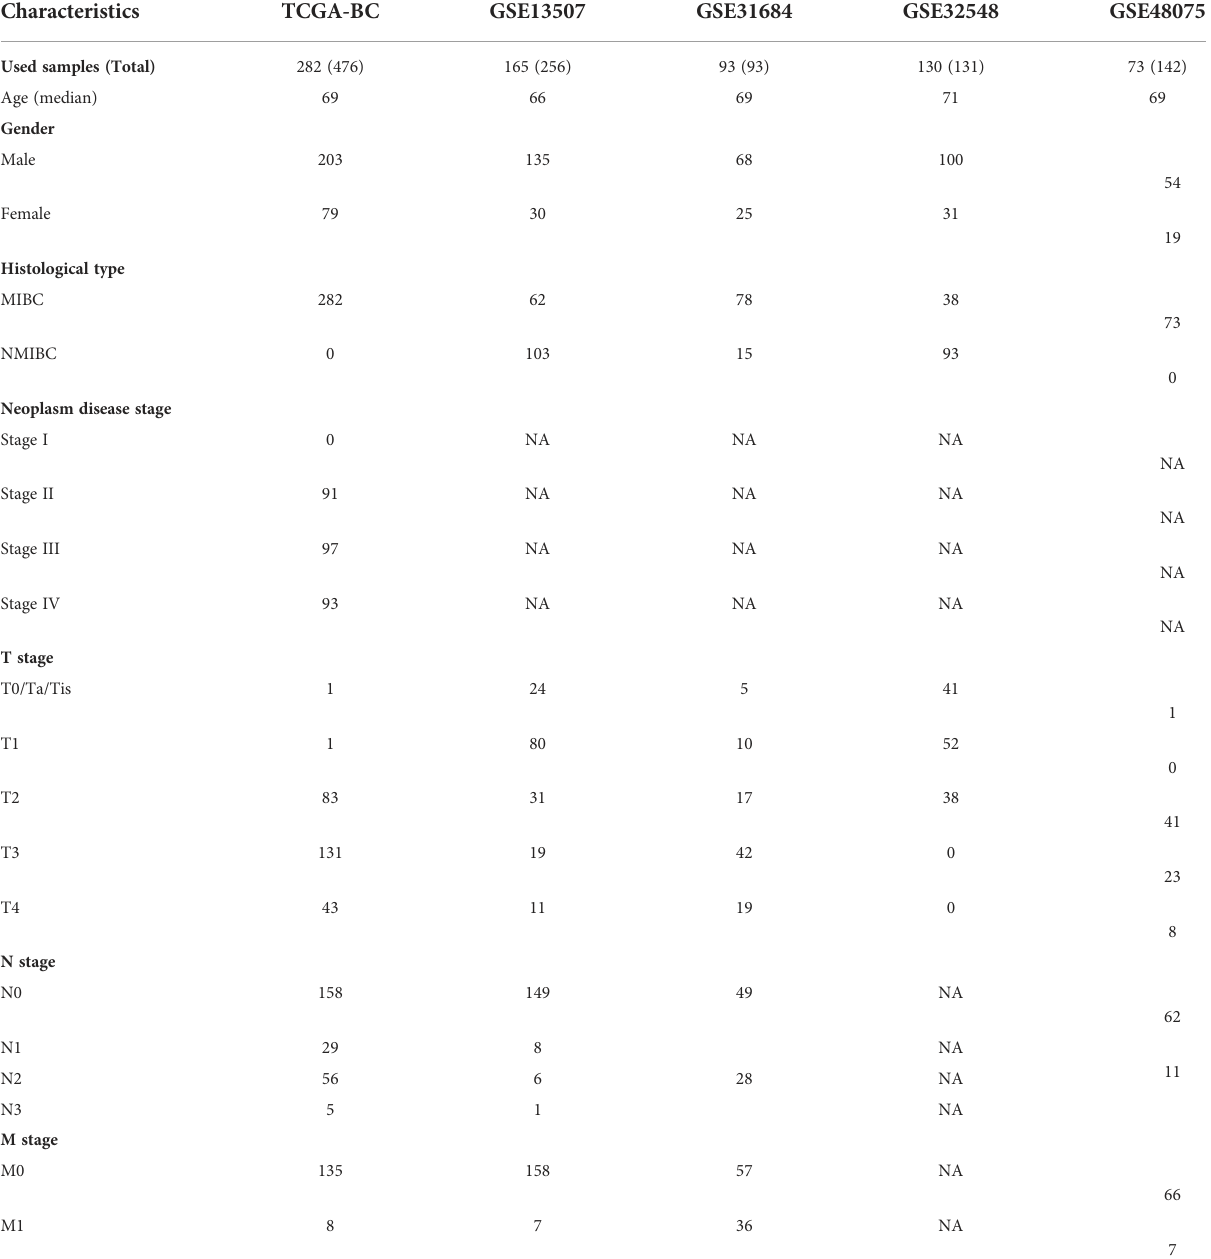
TABLE 1 Clinical characteristics of the BC patients in this